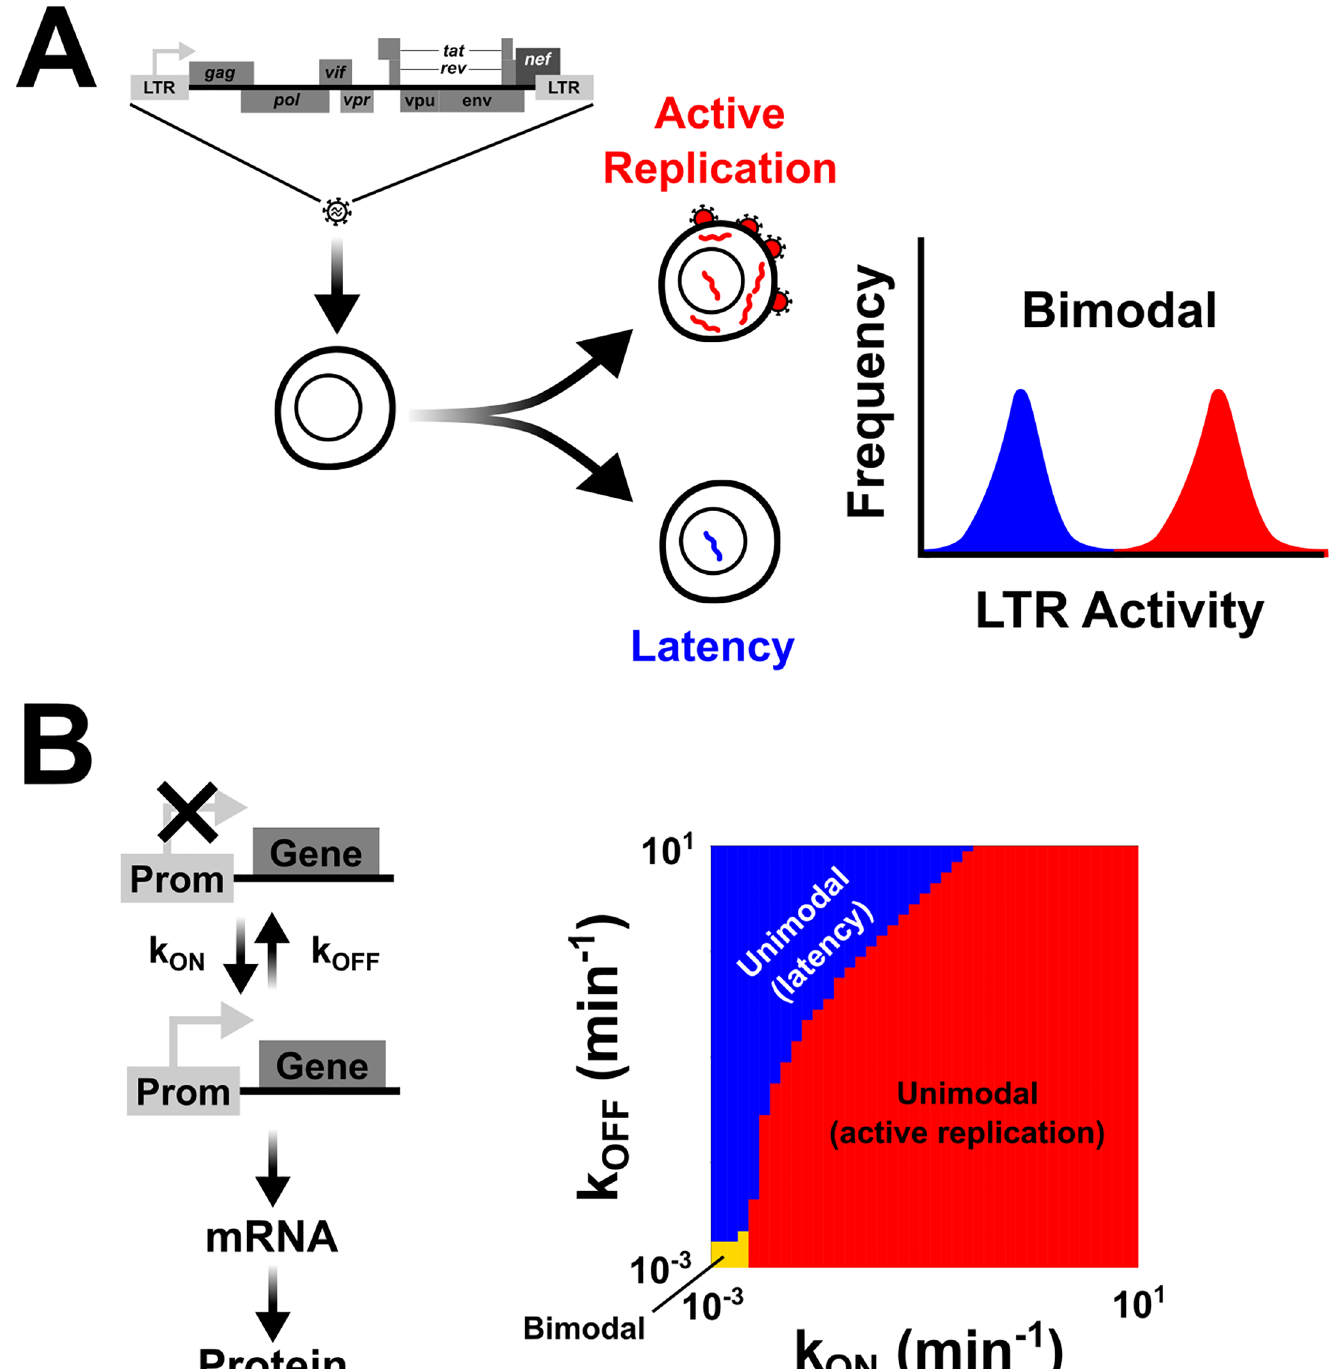
Fig 1. The mechanistic problem underlying bimodal fate-selection programs: Promoter toggling is theoretically sufficient to generate bimodality, but only in a narrow parameter regime. (A) A simplifiedfate-selection decisionin HIV. Upon infectionof a CD4 + T lymphocyte, HIV either enters into an active state of replication(red), producingviral progeny and destroyingthe host cell, or enters into a quiescentstate of silencedgene expressiontermed provirallatency (blue). This fate bifurcationbetweenactive replication and latency is not controlledby the cell state [27] but rather by an HIV gene-regulatory program that can generatebimodalgene-expression distributions from its long terminalrepeat (LTR) promoter. (B) The LTR is accuratelydescribedby a 2-state promoter model (e.g., random telegraphmodels)in which the LTR switches betweenan inactive (represented by Prom- Gene that is crossed out, top) to an active (represented by Prom-Gene) state of expressionat rate k ON . In the active state, mRNAs are produced, before the promoter flips back to the inactive state at rate k OFF . Promoter togglingbetweenthese active and inactive states can producebimodaldistributionsin